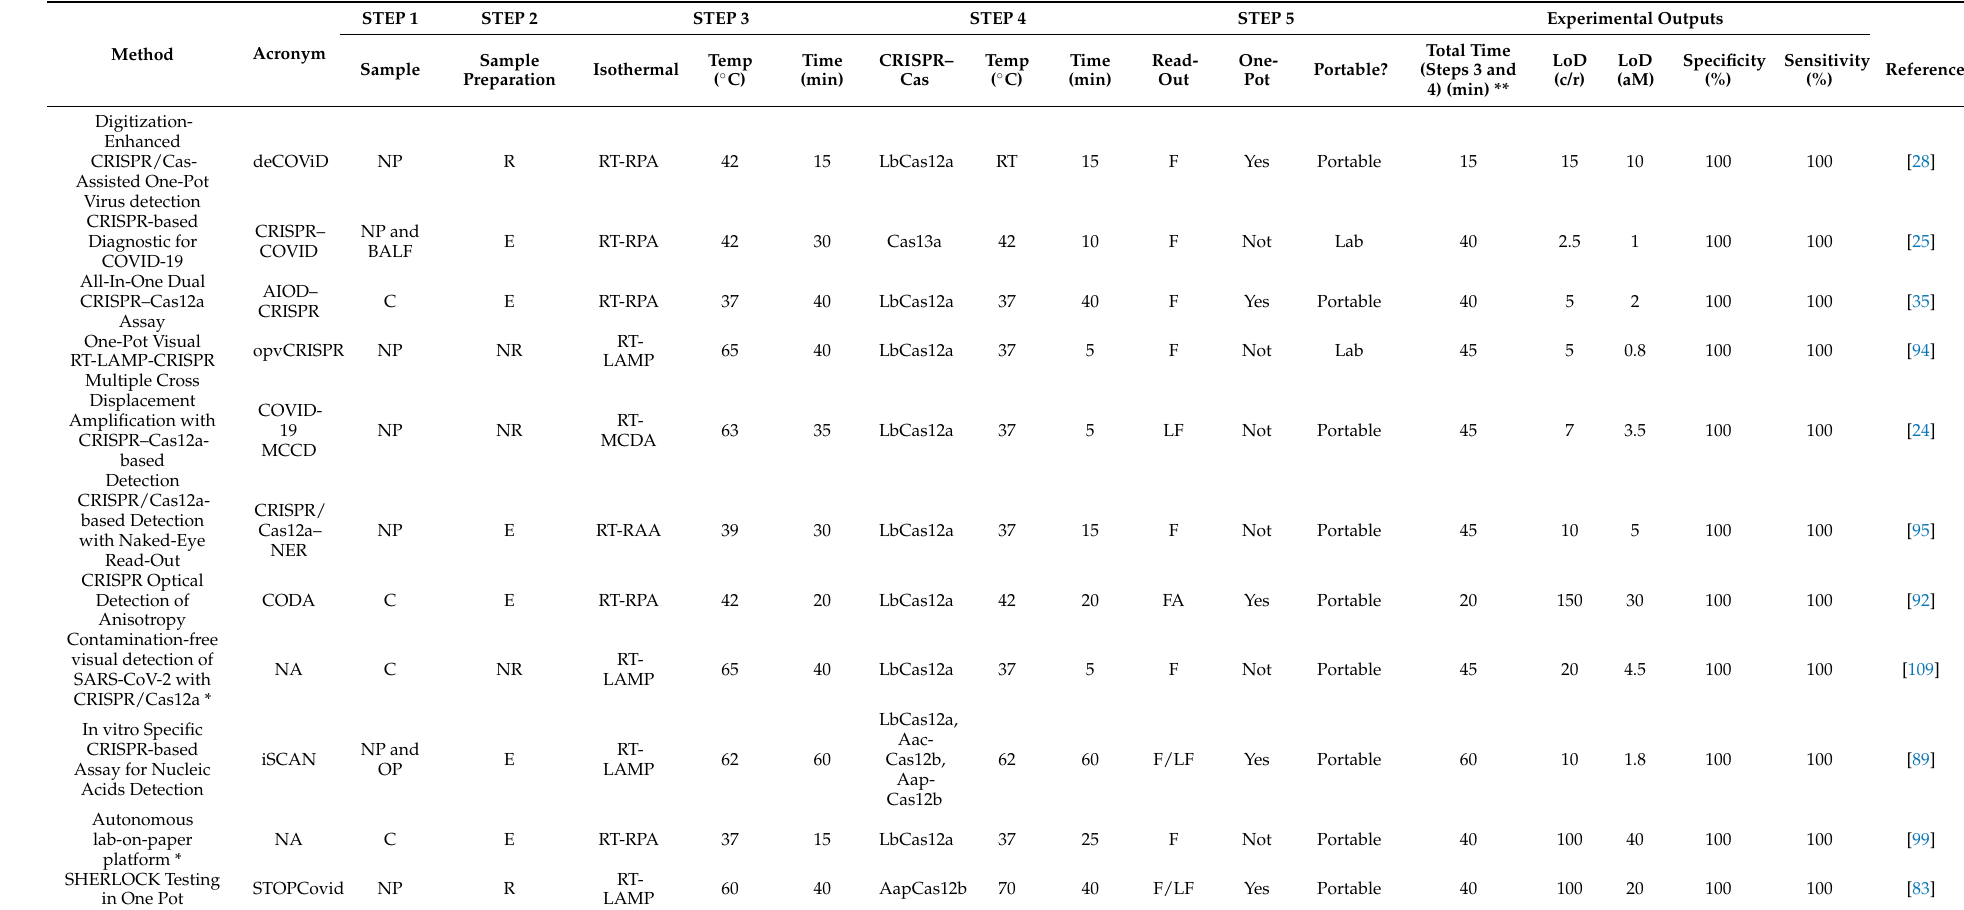
Table 6. Top CRISPR–Cas based methods to detect